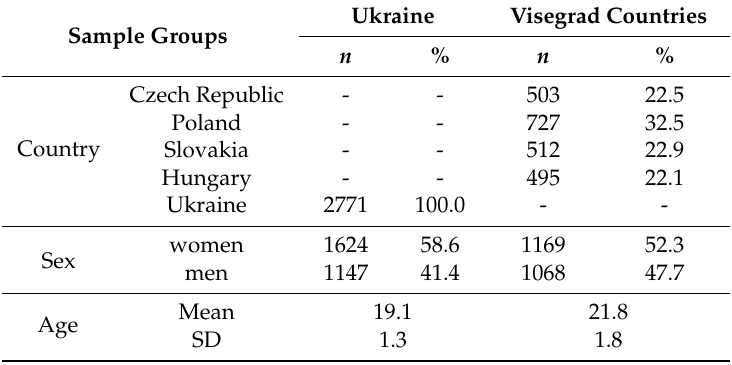
Table 1. Characteristics of the surveyed students from the Visegrad group and Ukraine.